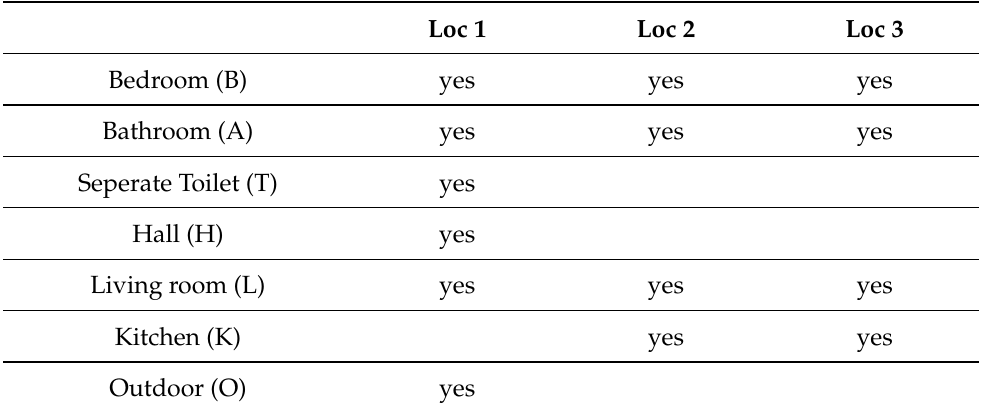
Table 1. An overview of the different rooms present at each